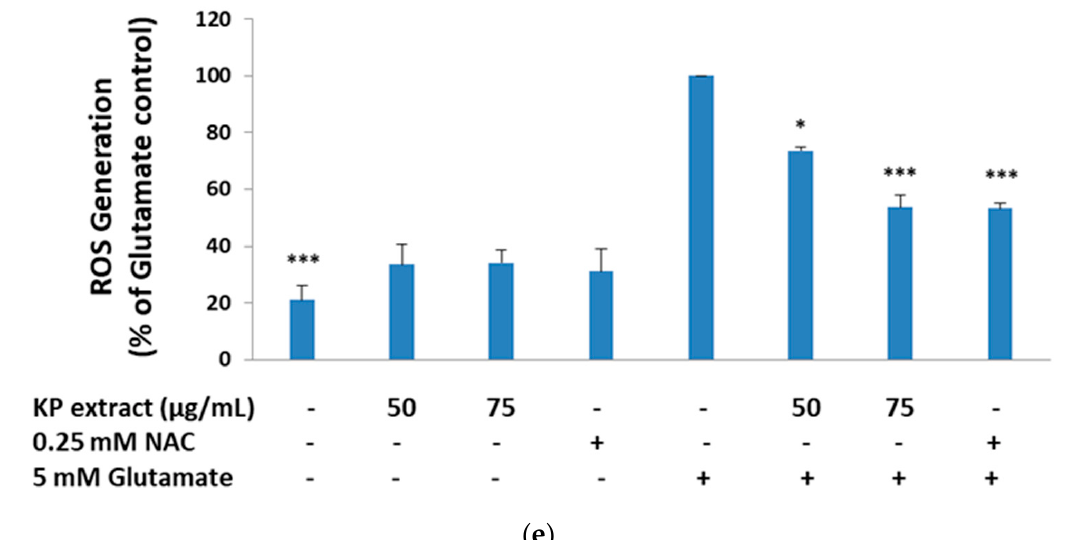
Figure 2. Inhibitory effect of KP extract against glutamate-induced oxidative stress in HT-22 cells. HT-22 cells were treated with 5 mM glutamate alone or co-treatment of glutamate with various concentrations of KP extract for 14 h. The production of intracellular reactive oxygen species (ROS) was stained by 2 ′ , 7 ′ -dichlorodihydro fluorescein diacetate (H 2 DCFDA) and observed under a fluorescence microscope. ( a ) Untreated cells (control); ( b ) 5 mM of glutamate; ( c ) 75 µ g/mL of KP extract + 5 mM of glutamate; ( d ) 0.25 mM of N-acetyl cysteine (NAC) + 5 mM of glutamate; ( e ) the quantity of production of intracellular ROS was measured using H 2 DCFDA by the fluorescence microplate reader. All data are shown as the mean ± SEM of at least three independent experiments. * p < 0.05 and *** p < 0.001 vs. the glutamate treatment alone. The symbol "-" and "+" are defined as absent and present, respectively.